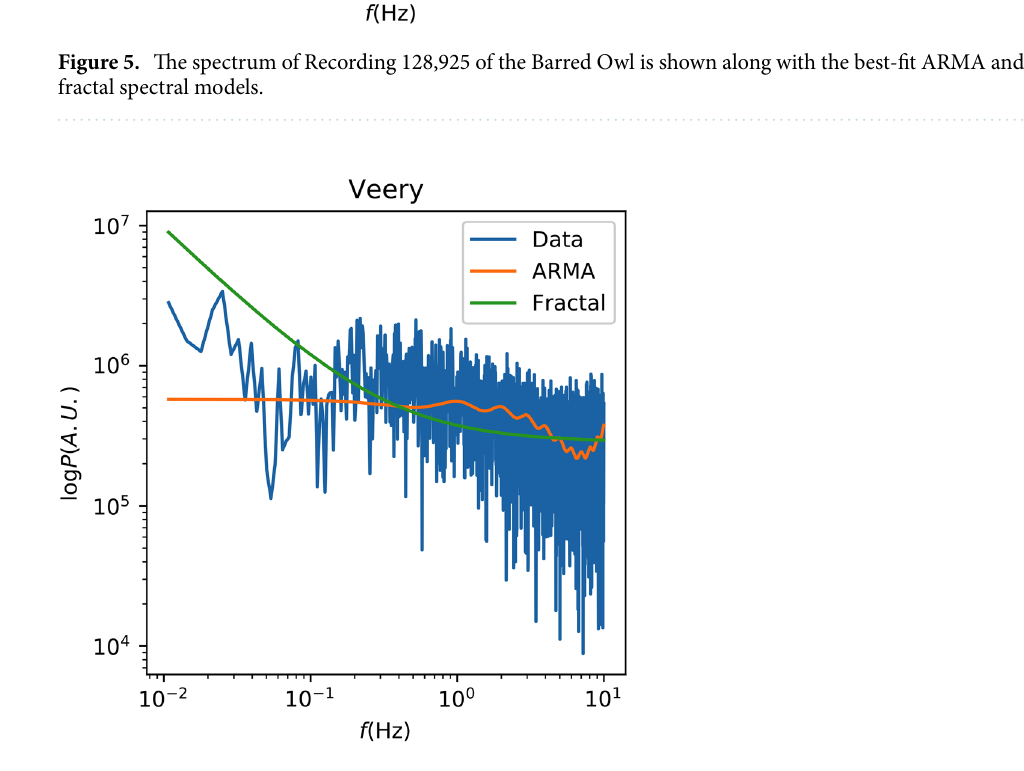
Figure 6. The spectrum of Recording 135,727 of the Veery Thrush is shown along with the best-fit ARMA and fractal spectral